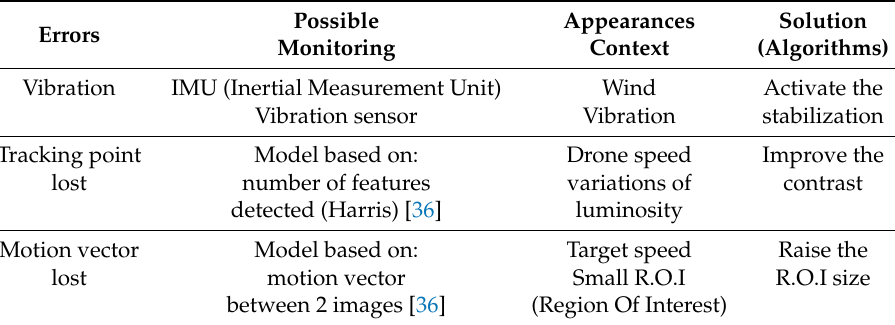
Table 6. Failure mode effects analysis applied to the tracking application.